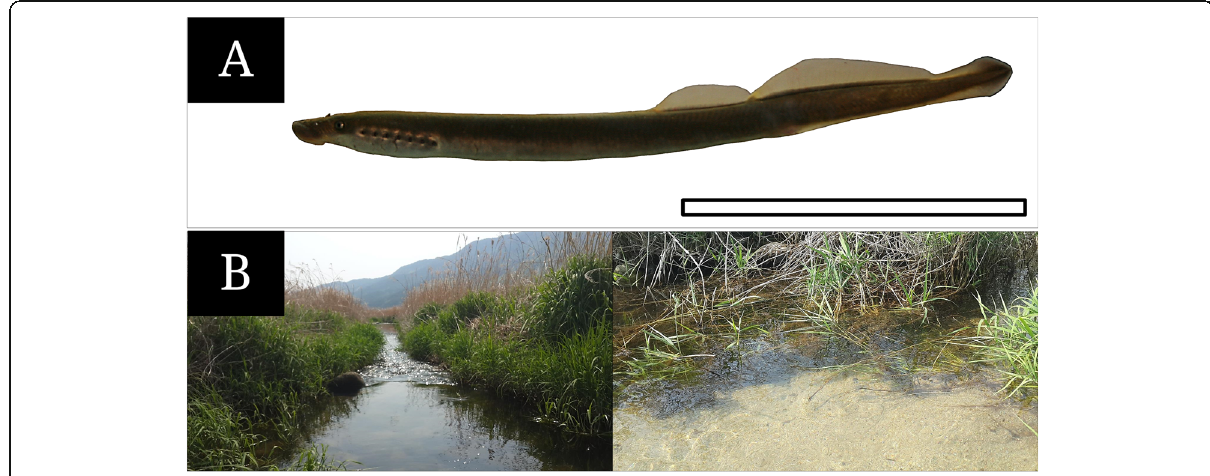
Fig. 1 The photographs of adult Lethenteron reissneri ( a ) and its habitats ( b , 35°29 ’ 40 ” N, 126°29 ’ 44 ” E). The bar indicates 5